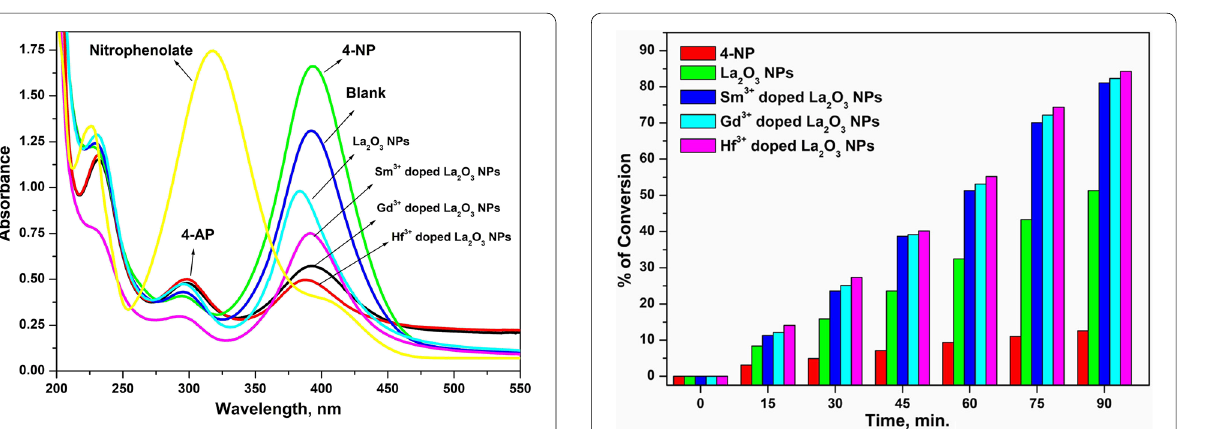
Fig. 9 The catalytic conversion of 4-NP using undoped and doped La 2 O 3 NPs catalyst in the presence of NaBH